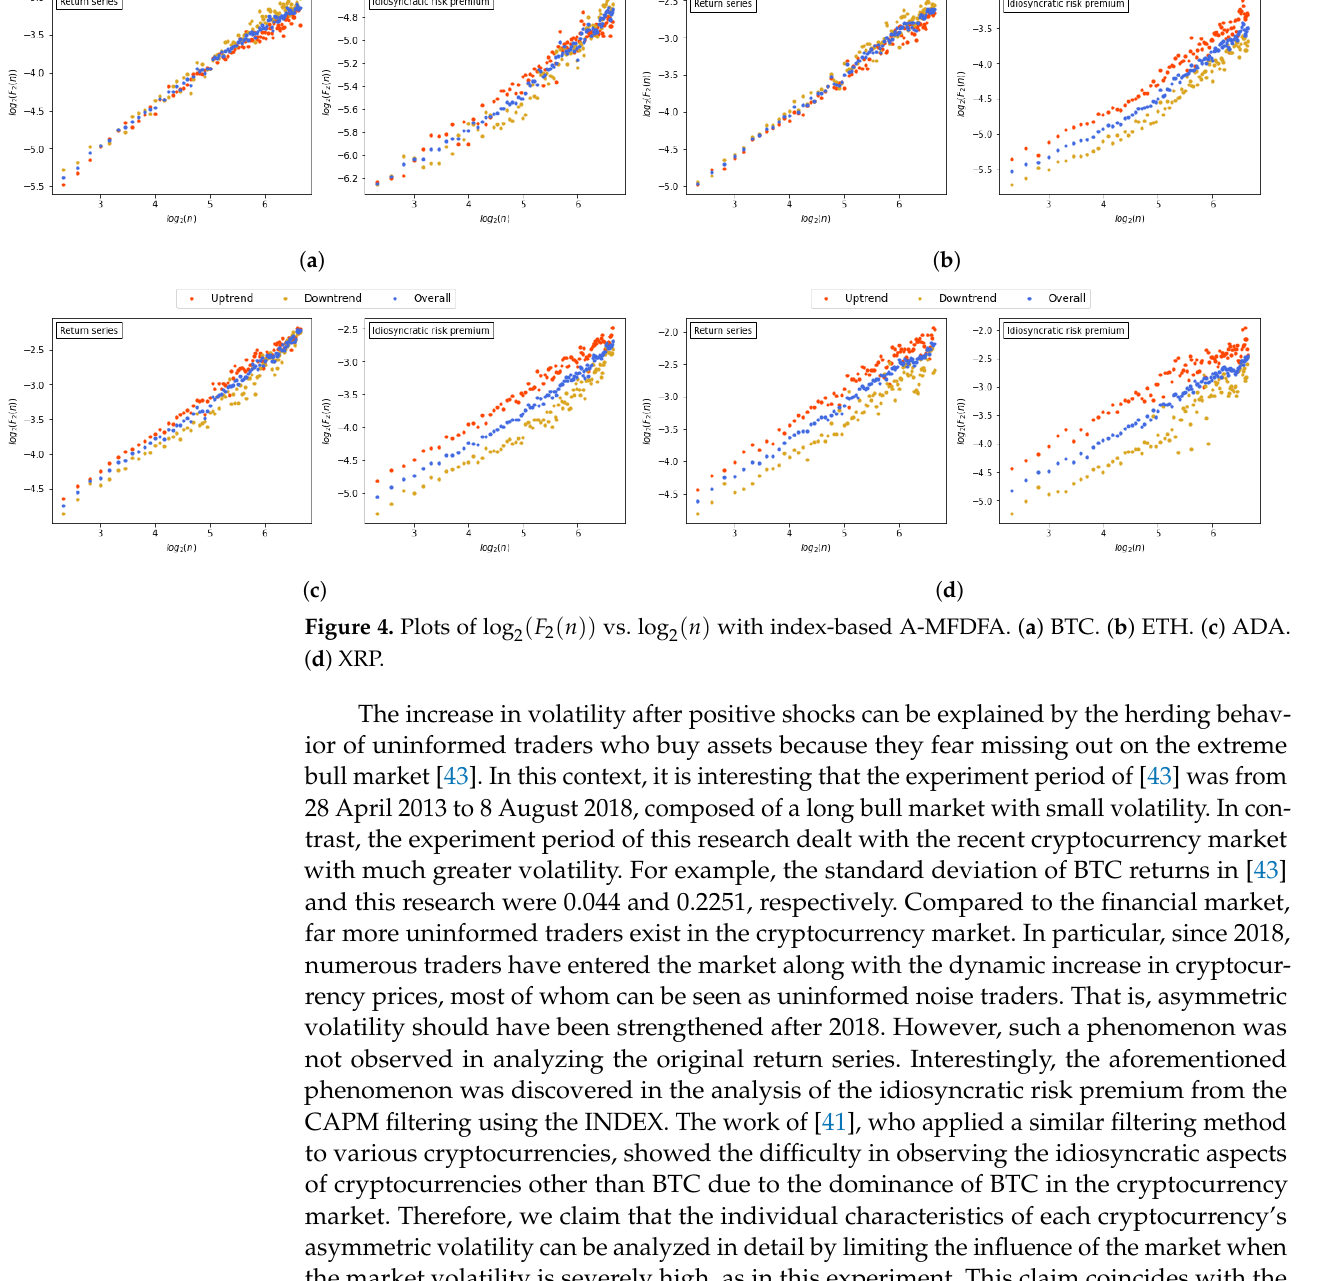
( F ( n )) vs. log ( n ) with index-based A-MFDFA. ( a ) BTC. ( b ) ETH. ( c ) ADA. 2 2 2